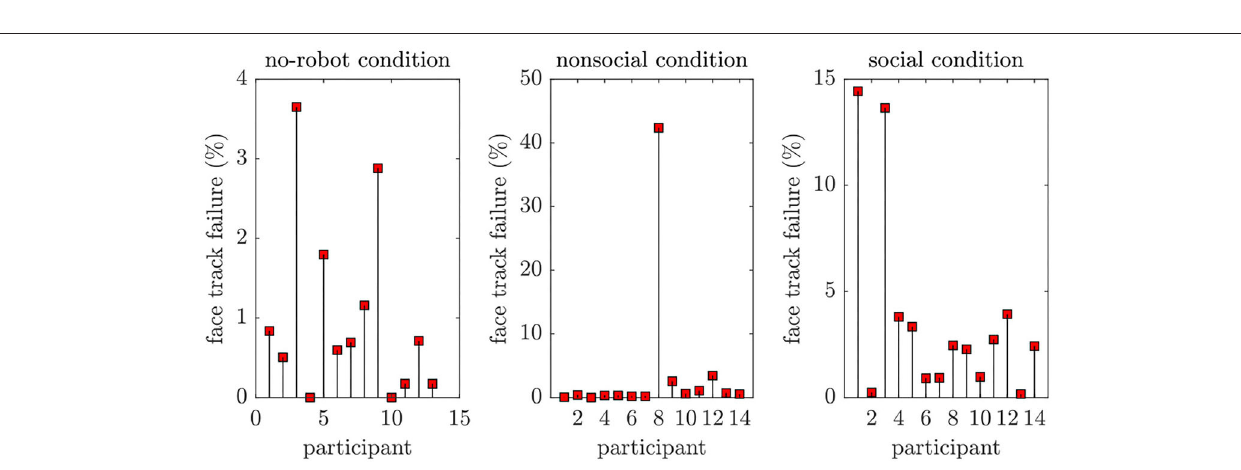
FIGURE 13 | Percentage of incorrectly tracked face (confidence < 0.7) considering all experimental phases (instructions, post-experiment phase). Although we only analyse the concrete experiment start and end phase, the general point here is that tracking failures can occur for more motion-intensive HRI